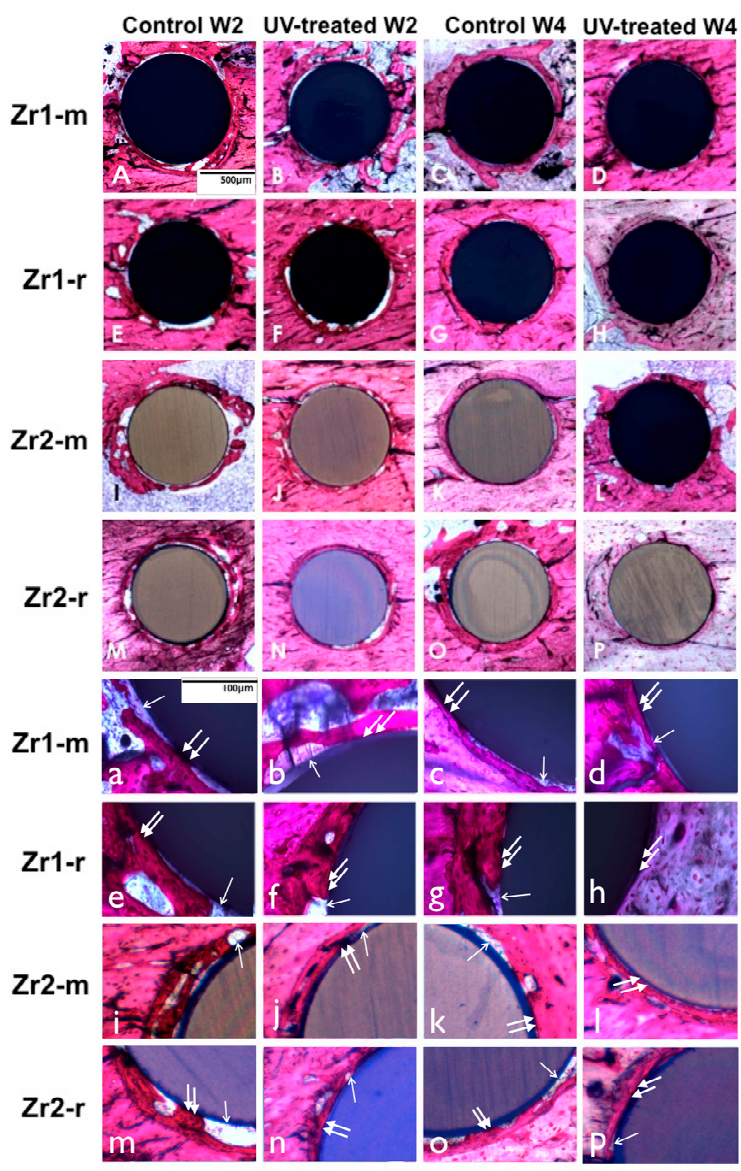
Figure 9. ( A – P ) UV light-promoted peri-implant bone generation at Weeks 2 and 4 of healing time. Representative histological images of the zirconia-based smooth and roughened implants with toluidine blue and Pararosanilin stain in an original magnification of 10× ( A – P ) and 40× ( a – p ). UV-treated implants are associated with a higher amount of bone-implant contact than non-treated implants. UV-treated implants at Week 2 (b,f,j,n) are associated with more vigorous bone formation with less interposition of soft tissue between the bone and the implant surface (arrowheads (b,f,j,n)); in contrast, the bone around untreated implants appears to be fragmentary (a,e,i,m) and involves more soft tissue (arrows (a,e,i,m)), interfering with the establishment of the direct bone implant contact; at Week 4, extensive bone spread can be observed along the implant surface without soft tissue interposition (arrowheads (d,h,l,p)) around UV-treated implants, whereas the bone around untreated implants is largely kept apart from the implant surface by soft tissue (arrows (c,g,k,o)). The histomorphometric evaluation of peri-implant bone revealed that UV treatment significantly increased the percentage of bone-implant contact around all samples ( p < 0.0001 and p < 0.05) (Figure 10A). The enhancement was 3–7-fold for smooth surfaces and 1.4–1.7-fold for rough surfaces at Weeks 2 and 4. Bone histomorphometry of UV-treated implants at Week 2